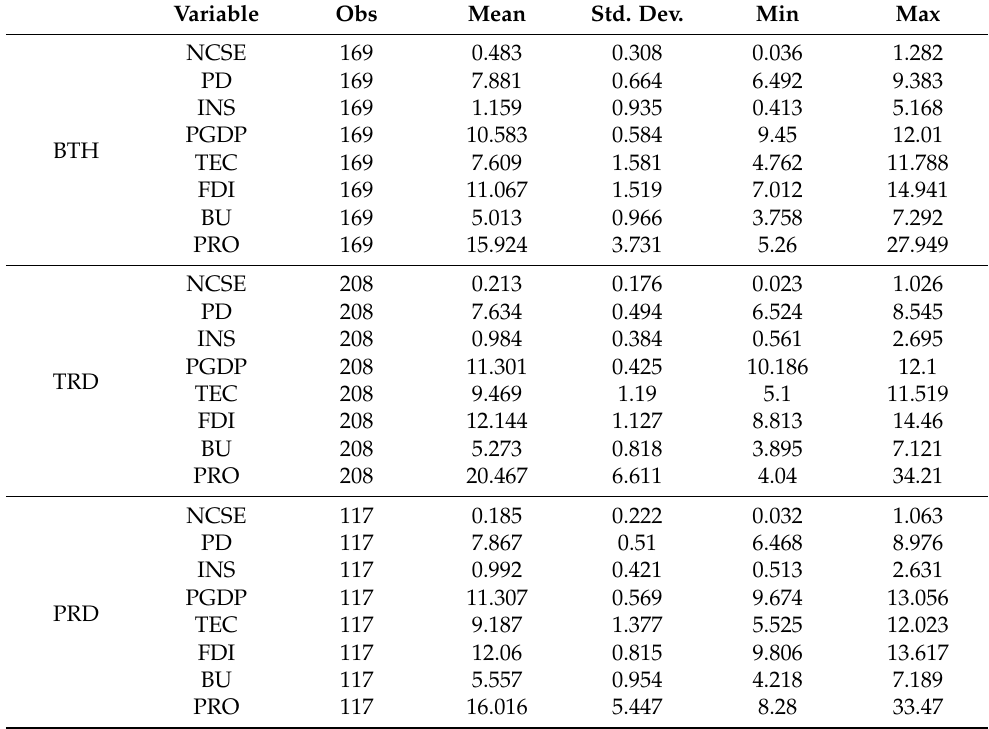
Figure 5. The NCSE STC diagrams of the three major UAs from 2007 to 2019. Table 4. The descriptive statistics of the influencing factors of the NCSE of the three major UAs.